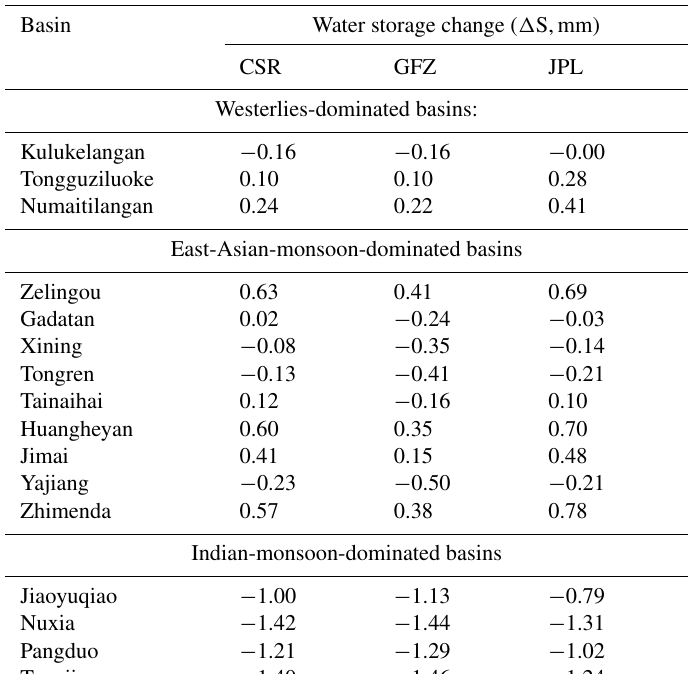
Table 3. Annual-averaged water storage changes ( (cid:49) S ) in 18 TP basins derived from GRACE retrievals (2002–2013) from three different processing centres (CSR, GFZ and JPL).